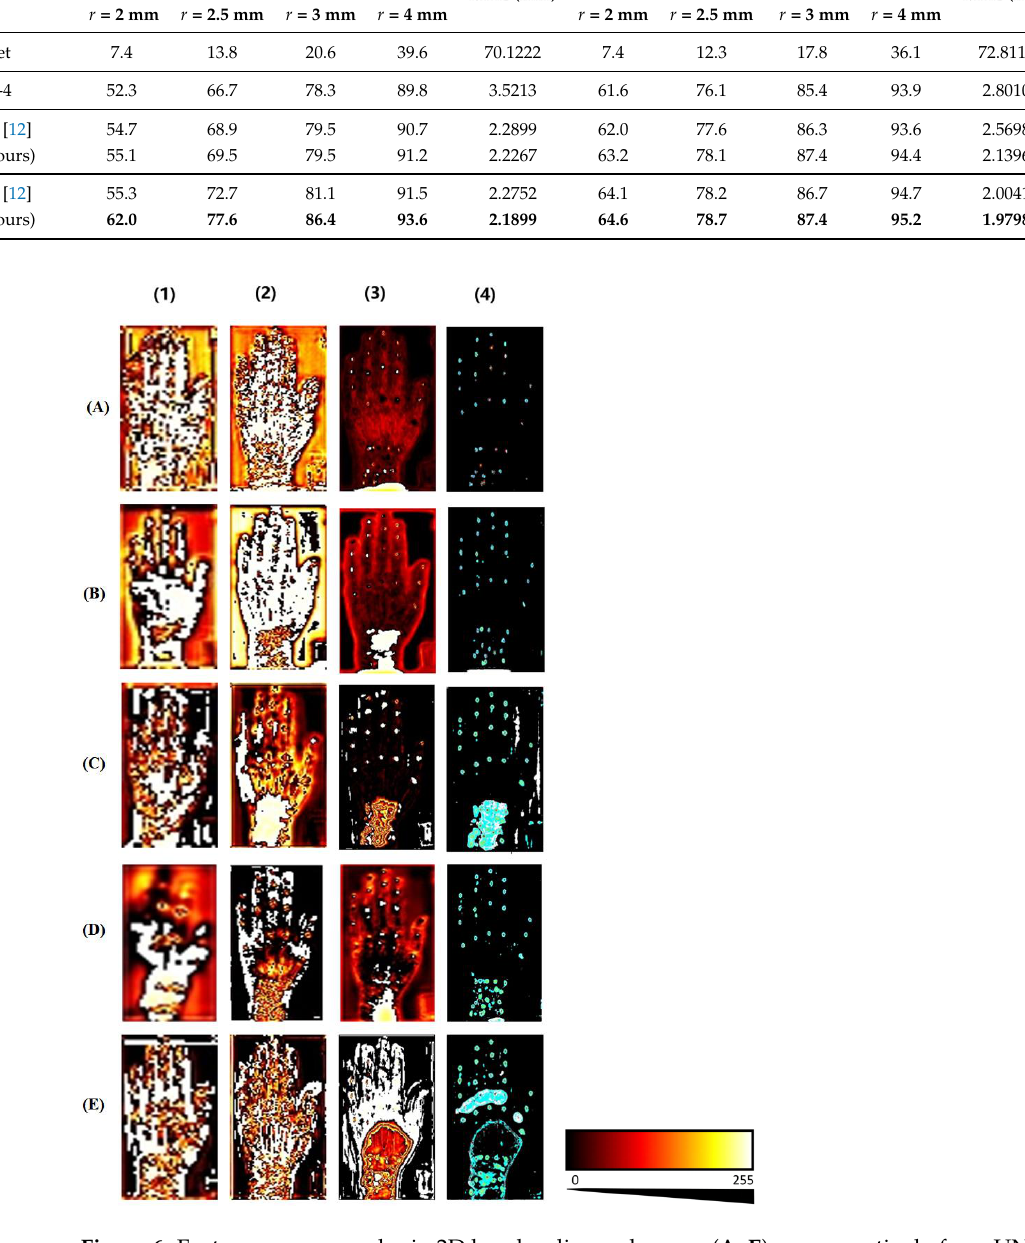
Figure 6. Feature map examples in 2D hand radiograph: rows ( A – E ) are respectively from UNet4, UNet4 with Fast-KD on UNet5, UNet4 with Fast-KD on SEG-UNet5, and UNet4 with FSF-LD on UNet5, UNet4 with FSF-LD on SEG-UNet5; columns ( 1 – 4 ) represent the output of the up3 block, the up4 block, and the final landmark detection heatmap, respectively. The RGB color value represents the amount of information contained in feature heatmaps. It intuitively shows the effect of our proposed improving-teacher method and FSF-LD. Pseudo color values: First, the feature map of the network output is normalized to between 0 and 1, and then mapped to 0–255, with each value representing a